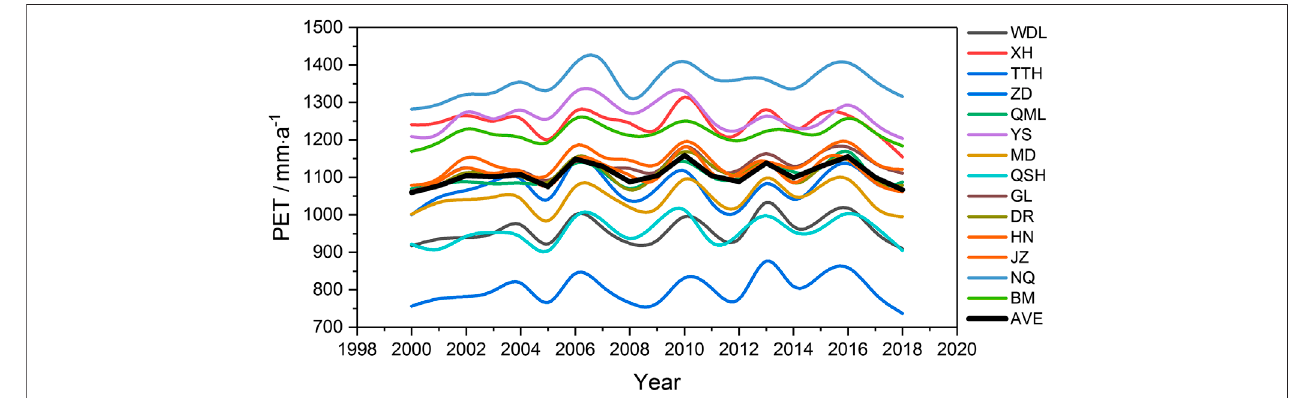
FIGURE 2 | The annual variation of potential evapotranspiration (PET) with 14 weather stations in the TRH from 2000 to 2018.